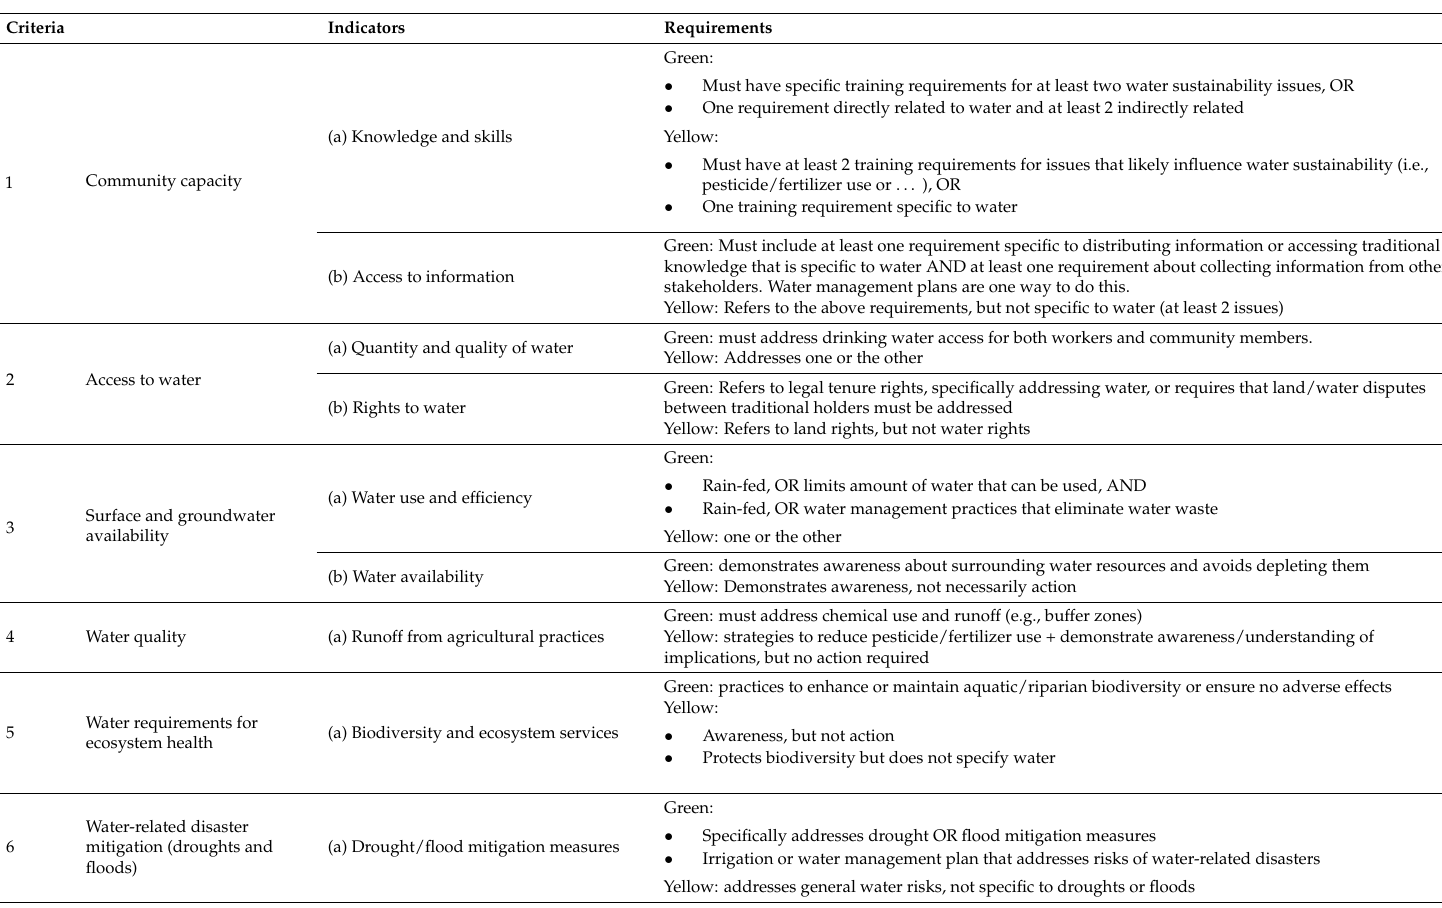
Table A1. Coding guide for Water Sustainability Framework. (Yellow: where no yellow requirements are indicated, the following apply: Criteria are not mandatory or do not require action; Green criteria are met, but not specific to water; Red: no